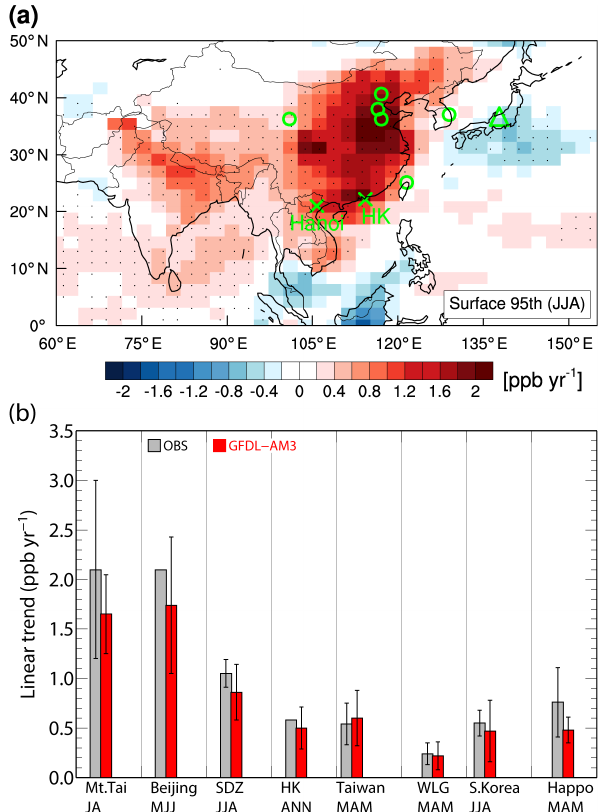
Figure 6. Surface O 3 trends in Asia. (a) Observation sites super- imposed on a map of the 95th percentile summer MDA8 O 3 trends over 1995–2014 from AM3 BASE. (b) Comparison of median O 3 trends from AM3 (1995–2014) with observations (see text for pe- riods): in central eastern China at Mt. Tai (July–August, Sun et al., 2016), Beijing (May–June–July, Ding et al., 2008) and Shangdianzi (SDZ) (JJA, Ma et al., 2016); in South China at Hong Kong (HK) (annual average, Wang et al., 2009) and Taiwan (MAM, Lin et al., 2010); at Mt. Waliguan (WLG) in western China (MAM, Xu et al., 2016); in South Korea (JJA, Lee et al., 2014) and Mt. Happo Japan (MAM, Tanimoto, 2009). For Mt. Happo (triangle on map) AM3 is sampled at 700hPa and filtered for the influence from Asian conti- nental air – more representative of observed baseline conditions in